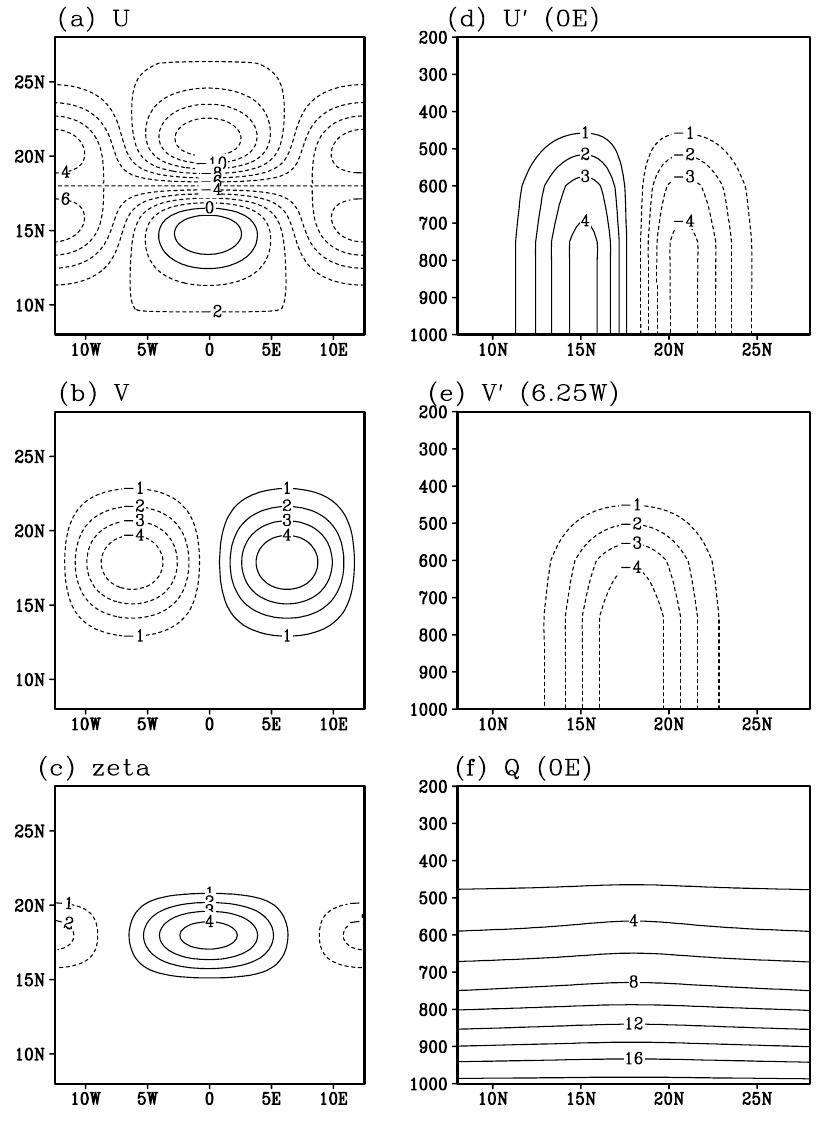
Fig. 4. The left panels show the initial zonal wind ( a ; unit: ms − 1 ) , meridional wind ( b , ms − 1 ) and relative vorticity ( c ; unit: 10 − 5 s − 1 ) at the surface, and the right panels show the vertical cross section of the initial zonal wind perturbations (d) , meridional wind perturbations (e) and mixing ratio Q ( f ; unit: g/kg). Perturbations are defined as the difference between the total field and the basic state.